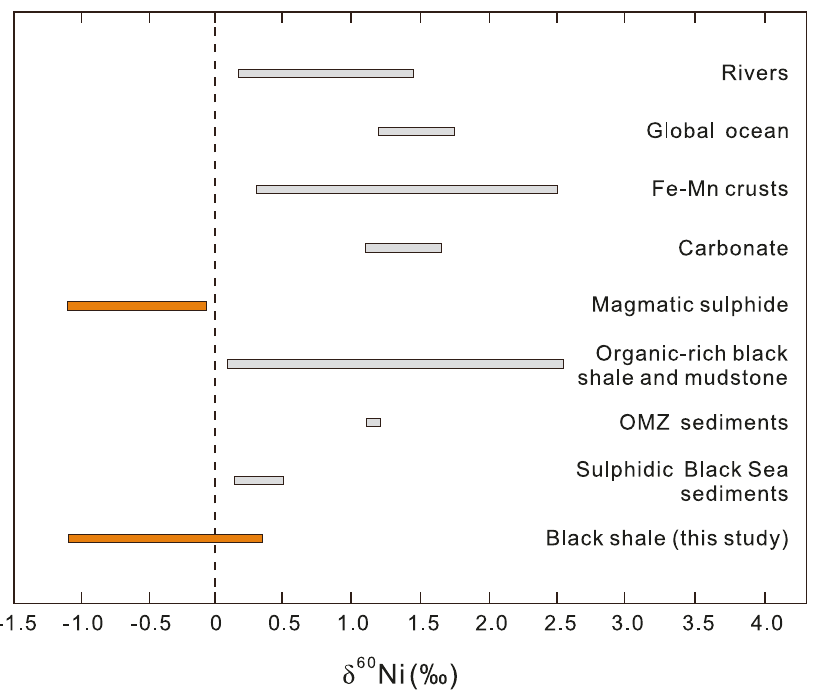
Fig. 3 Summary of the Ni isotopic compositions reported in this study and previously published data. Rivers and the global ocean are from ref. 36 , and Fe – Mn crusts are from refs. 35,45 . Carbonates and OMZ sediments are from ref. 43 . Magmatic sulphides are from refs. 38,48 . Organic-rich black shale and mudstone are from ref. 47 and sulphidic Black Sea sediments are from ref. 33 . The comparable light Ni isotopic compositions between the magmatic sulphides and our data are highlighted in